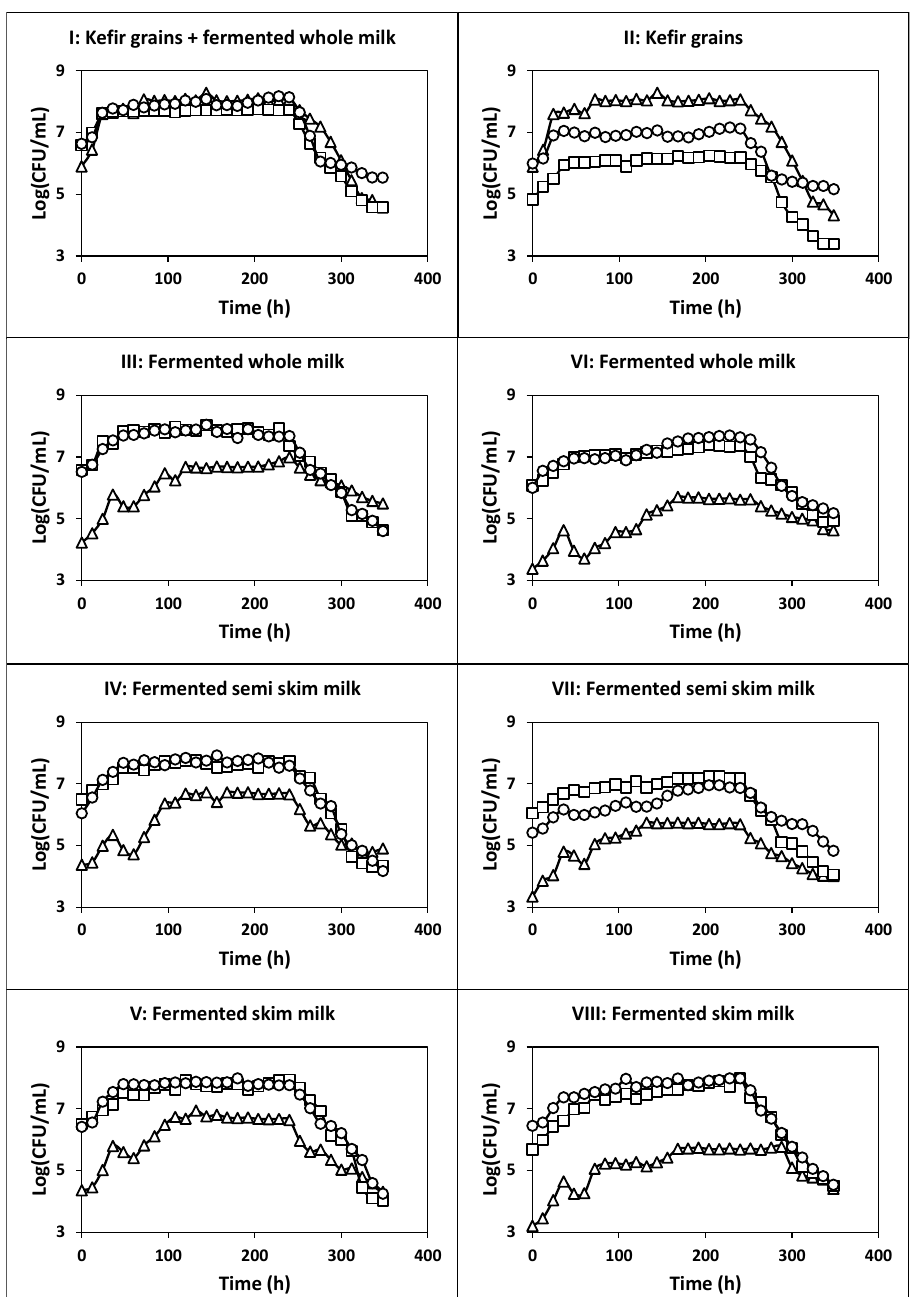
Figure 4. Kinetics of growth of viable LAB ( circles ), AAB ( squares ) and yeasts ( triangles ) in the different fed-batch fermentations in deproteinized whey. In fermentations III, IV and V, the culture medium was inoculated with milk fermented with kefir grains with agitation at 150 rpm. In fermen- tations VI, VII and VIII, the culture medium was inoculated with milk fermented with kefir grains under static conditions.